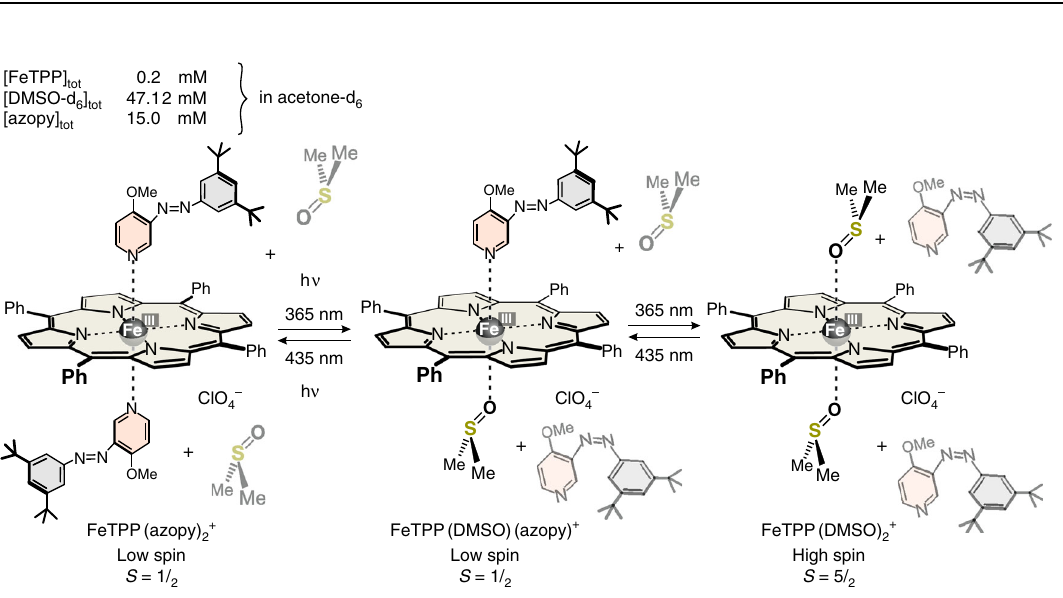
At the photostationary state generated upon irradiation with light of 435nm (PSS 435nm), the combined concentration of low-spin species is 91.9%, and at PSS 365nm this concentration decreases to 15.7%. Hence, the switching ef fi ciency is